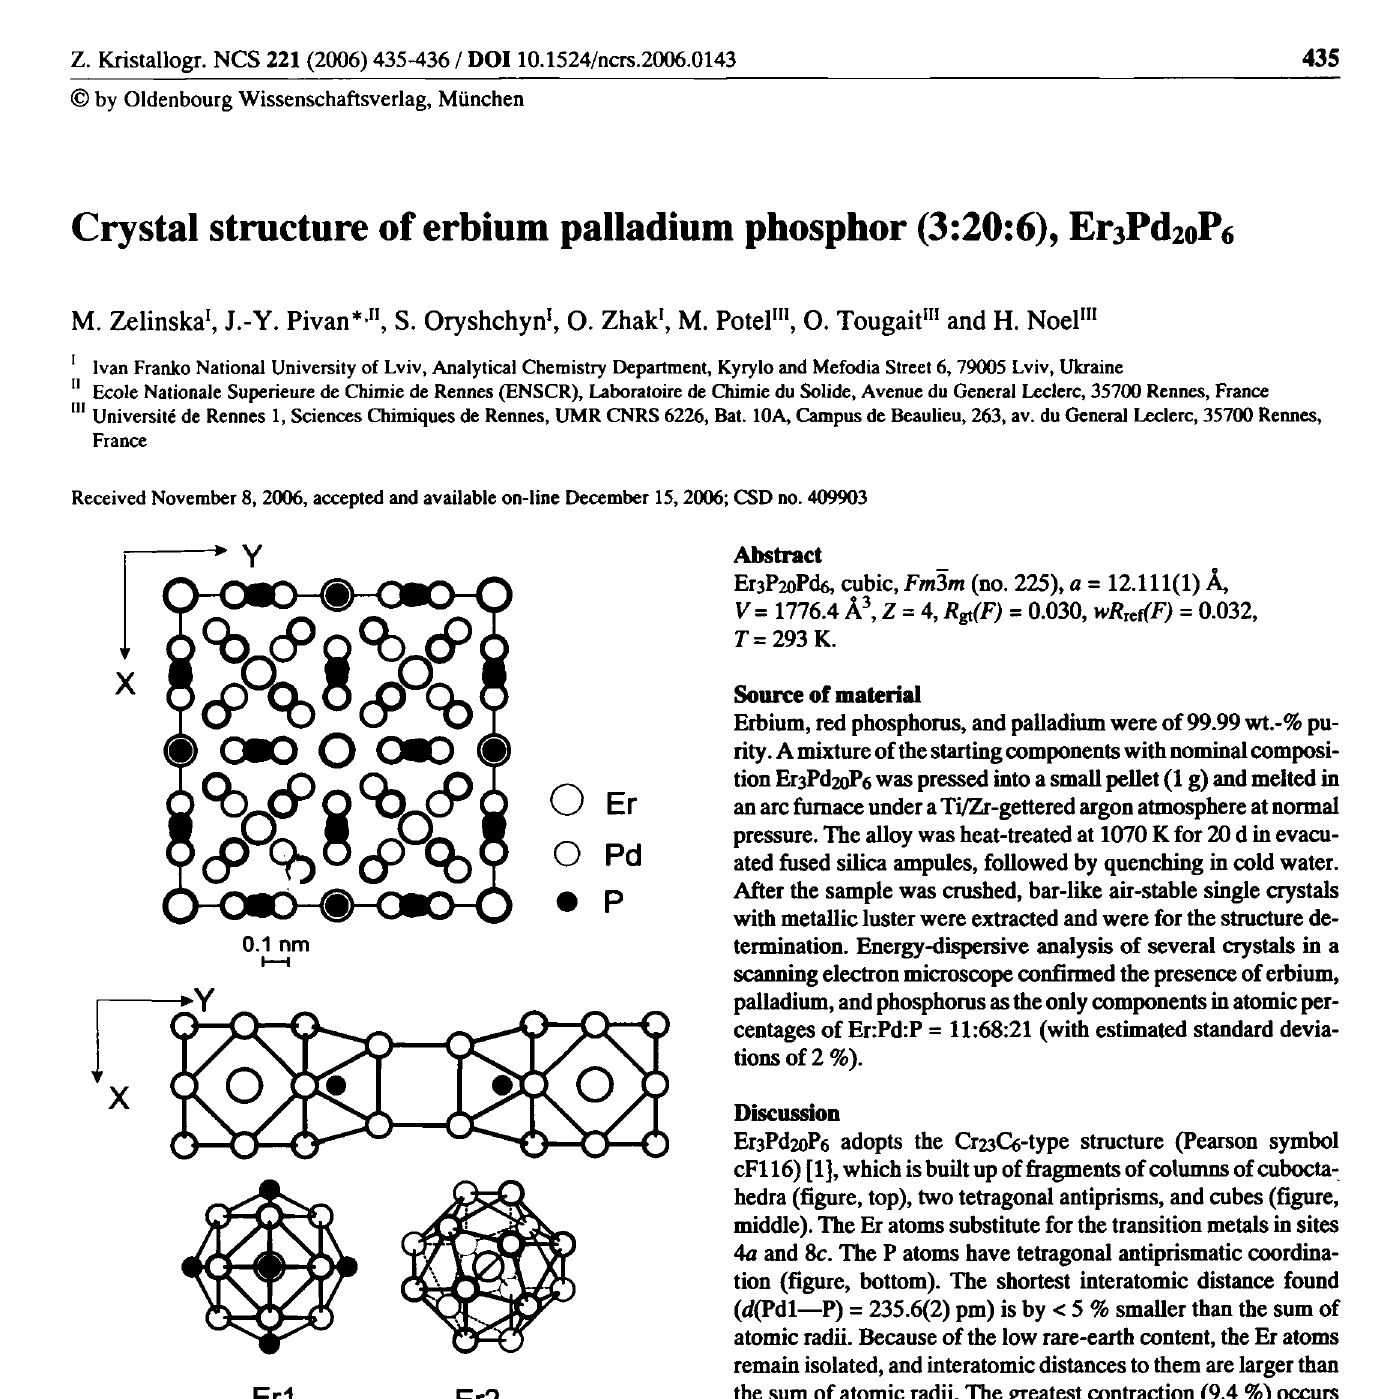
Table 1. Data collection and handling. Crystal: Wavelength: μ· Diffractometer, scan mode: